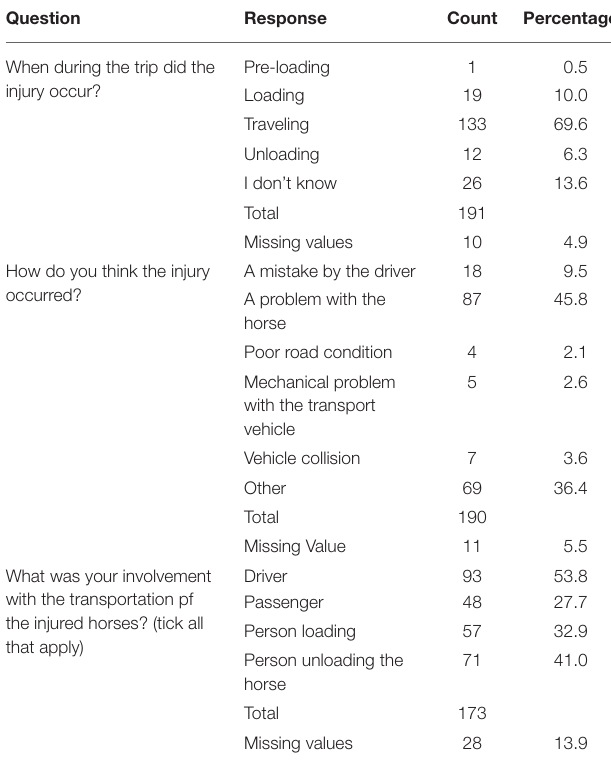
TABLE 3 | Frequency table for injury related questions of respondents ( n = 201) who affirmed having had at least one horse injured during a previous 2 years before completing a survey on horse transportation practices in New